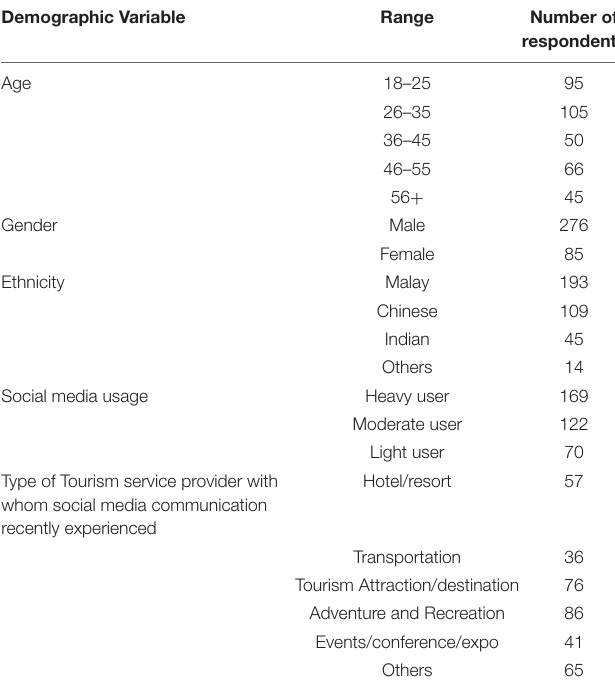
TABLE 5 | Demographics of the